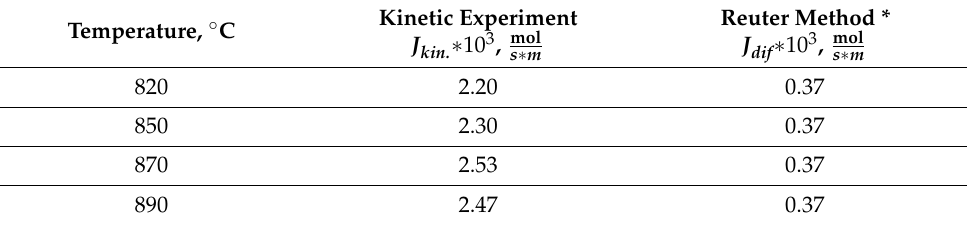
Table 5. Comparison of the results of the kinetic experiment and the experiment to determine the effective diffusion coefficient of methane